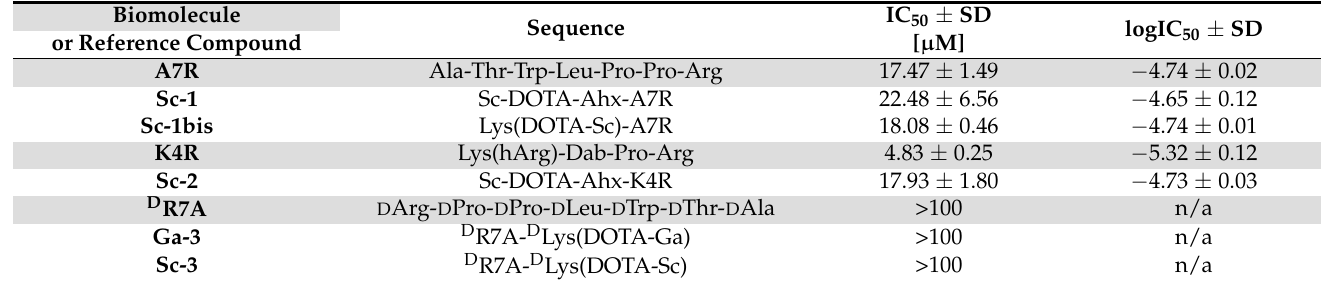
Table 2. Inhibitory effects of Sc-1 , Sc-1bis , Sc-2 , Sc-3 and Ga-3 compounds on the VEGF-A 165 /NRP-1 complex formation in competitive ELISA test (presented as the mean ± SD, n =